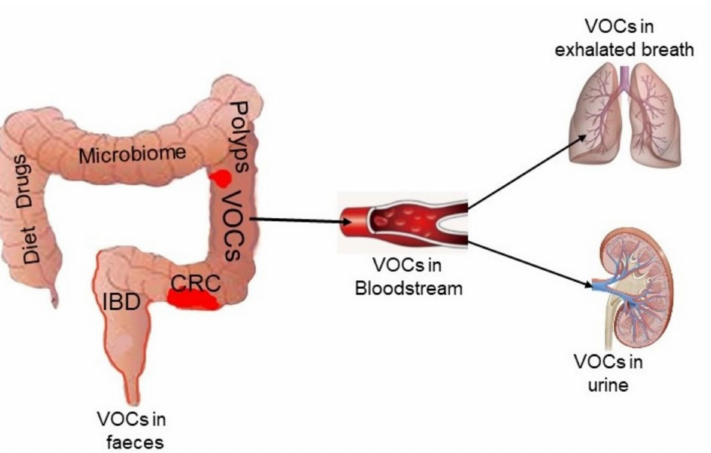
Figure 1. Volatile organic compounds (VOCs) are produced during physiological and pathological processes including colonic inflammation and neoplasia. VOCs can also originate from exogenous sources such as food and drugs and microbiome metabolism. Once produced, VOCs are released into the gut and detectable in the intraluminal content or feces, or released into the bloodstream and then reach the pulmonary alveoli or renal tubules where they are excreted and therefore measurable in the exhaled breath and urine, respectively. IBD = inflammatory bowel disease; CRC = colorectal cancer. The origin of individual VOCs is still a matter of debate, but largely depends on the interaction between diet and microbiota. The relationship is complex and bidirectional in normal subjects as gluten-free diet [17], ketogenic diets [18], low FODMAP diet [19] as